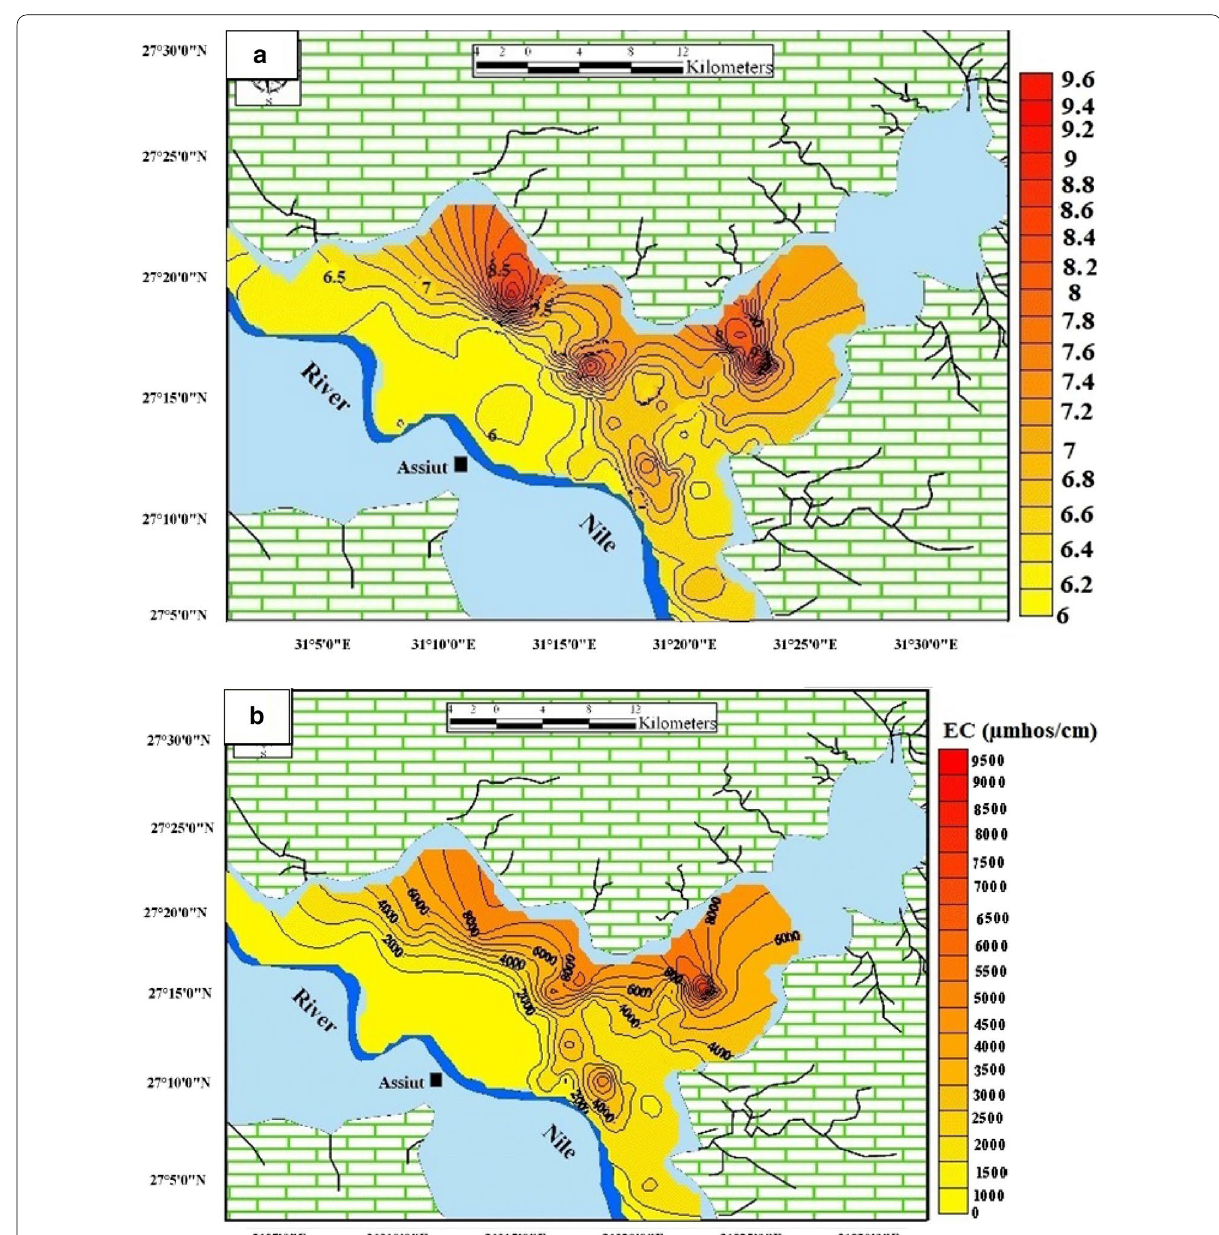
Fig. 4 a Concentrations of hydrogen ions (pH) and b electrical conductivity (EC) values of groundwater samples in the study